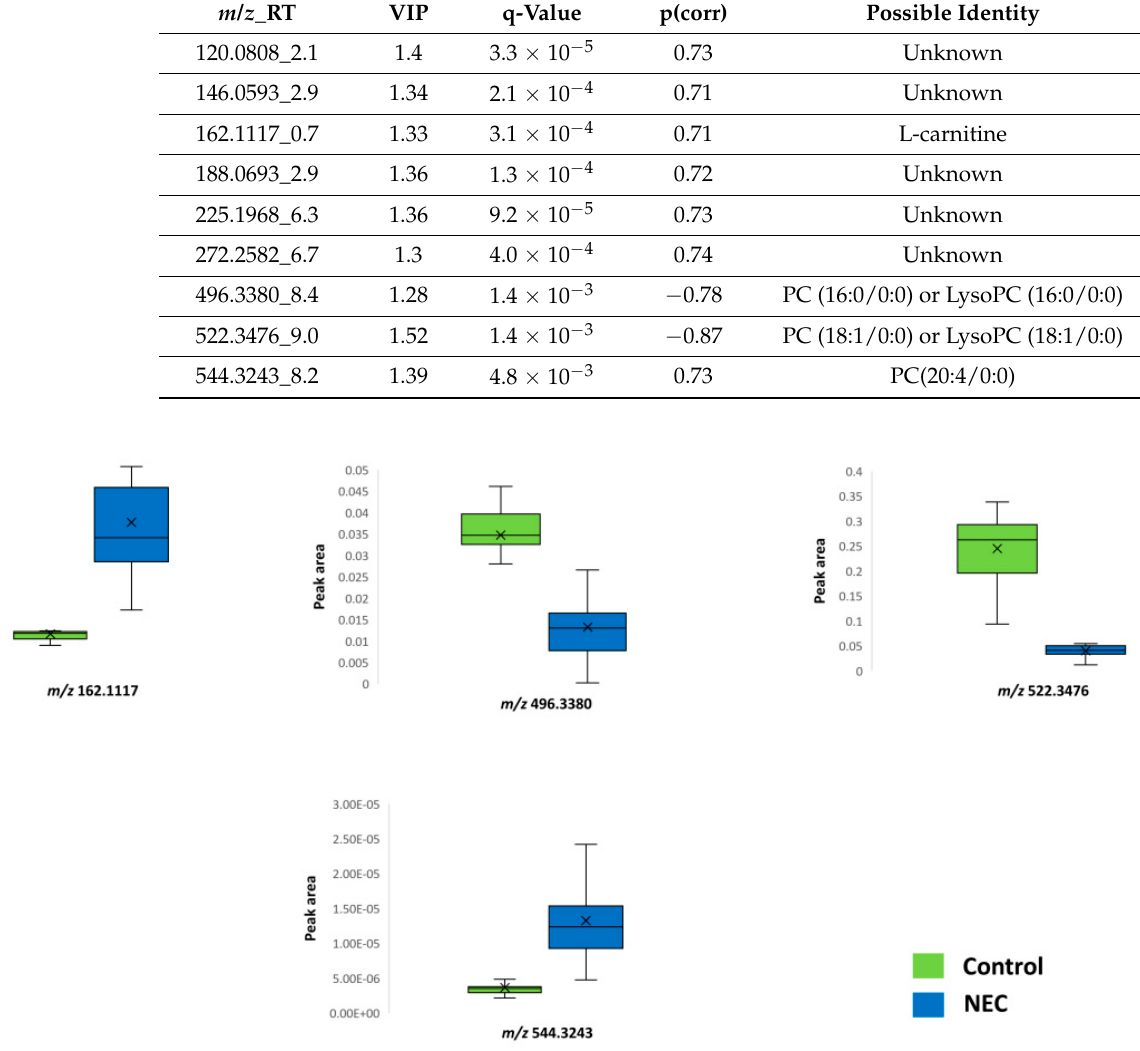
Figure 4. Box plots of significant metabolites in the control and necrotizing enterocolitis (NEC) groups.